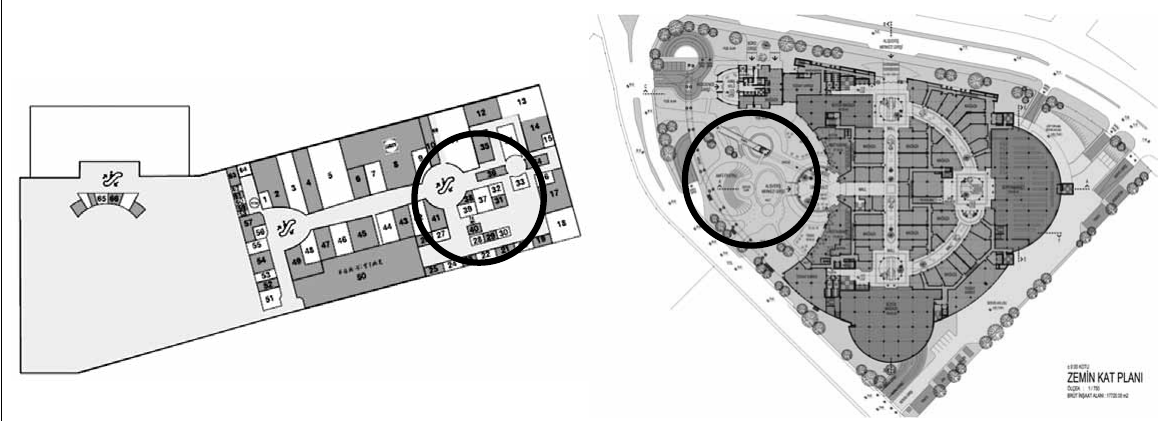
fig. 9. alternative circulation